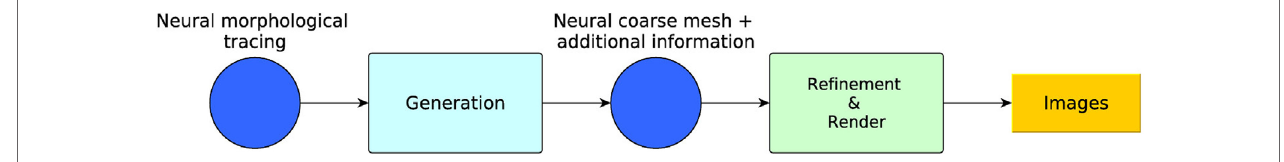
FIGURe 1 | Method overview: generation and refinement modules. From the morphological tracing, a coarse mesh is generated with additional information. A dynamically adaptive LOD refinement is then applied to the coarse mesh for its real-time